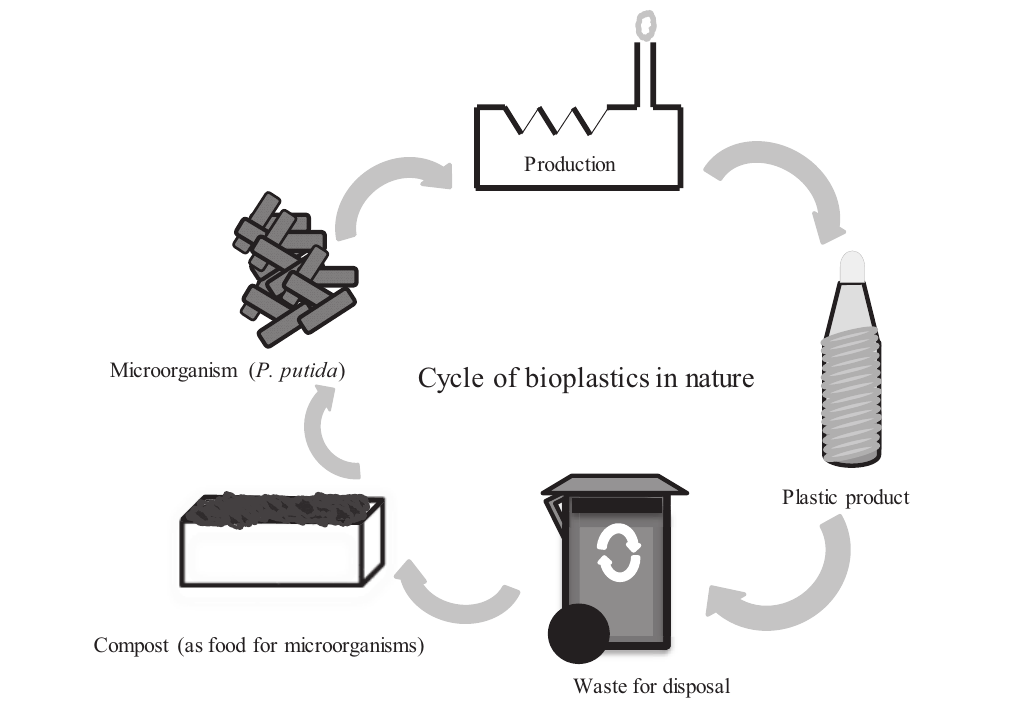
Fig. 1 – Bioplastics cycle. Bioplastics are produced by microorganisms, which are collected after being used as solid wastes. These are degraded and used as carbon sources for the microorganisms.